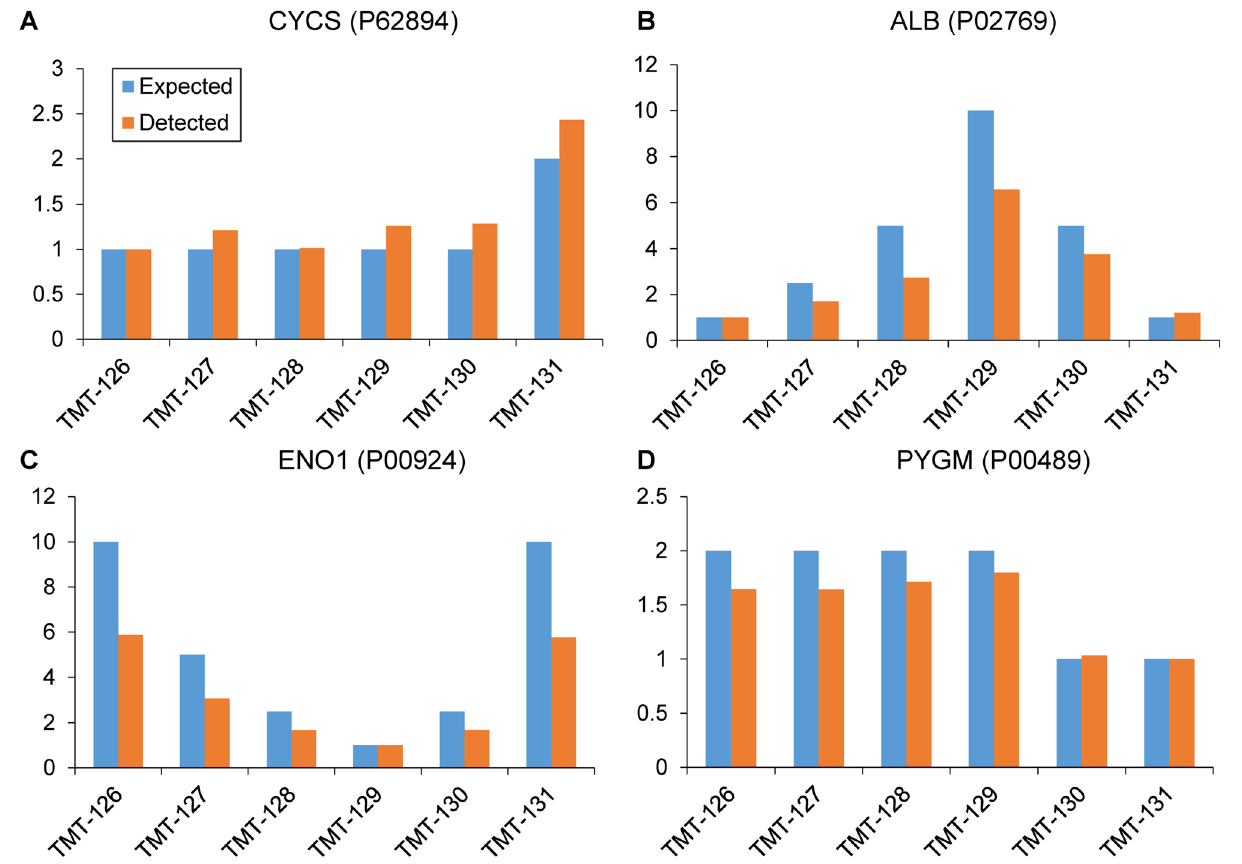
Fig 3. Comparison of the expected ratios with detected ratios. The expected ratios and detected ratios are provided for the four standard proteins: P62894 (A), P02769 (B), P00924 (C) and P00489 (D). The gene name for each protein is also shown in the